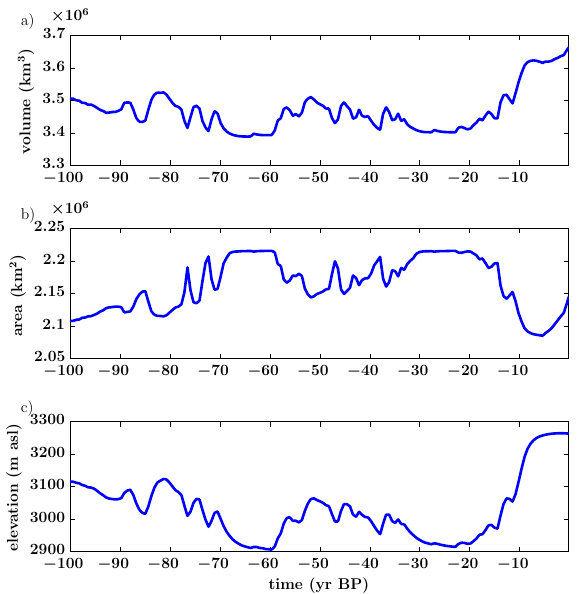
Figure 6. Time series of total GIS volume (a) , GIS area (b) and GIS summit elevation (c)